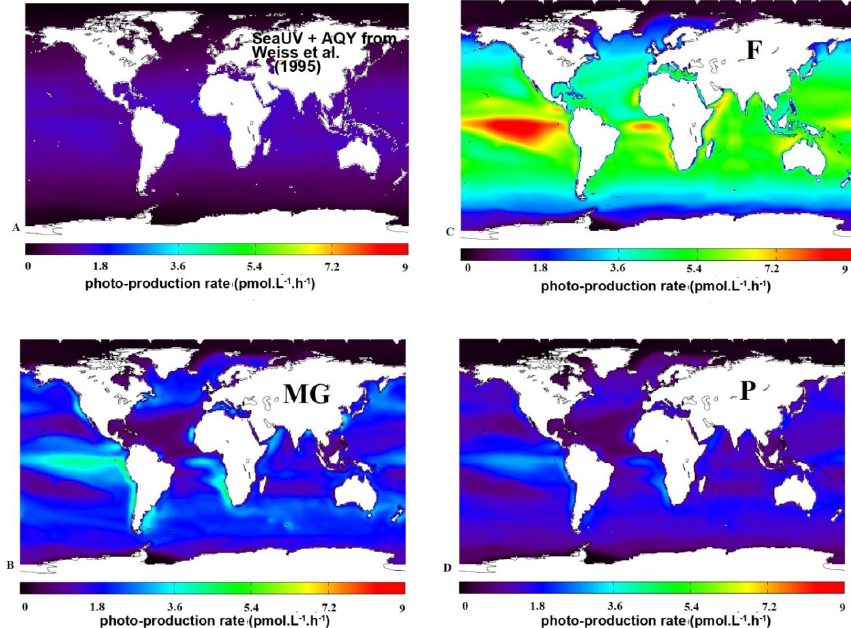
Figure 7. Annual mean photo-production rates integrated over the entire water column simulated with the photochemical model of Fichot and Miller (2010) and using the apparent quantum yield of Weiss et al. (1995a) (a) . Comparison with annual mean photo-production rates integrated over the entire water column simulated with the NEMO-PISCES model using a 350 formulations from Morel and Gentili (2009) (c) , Preiswerk and Najjar (2000) (d) and proposed in this study (b) .